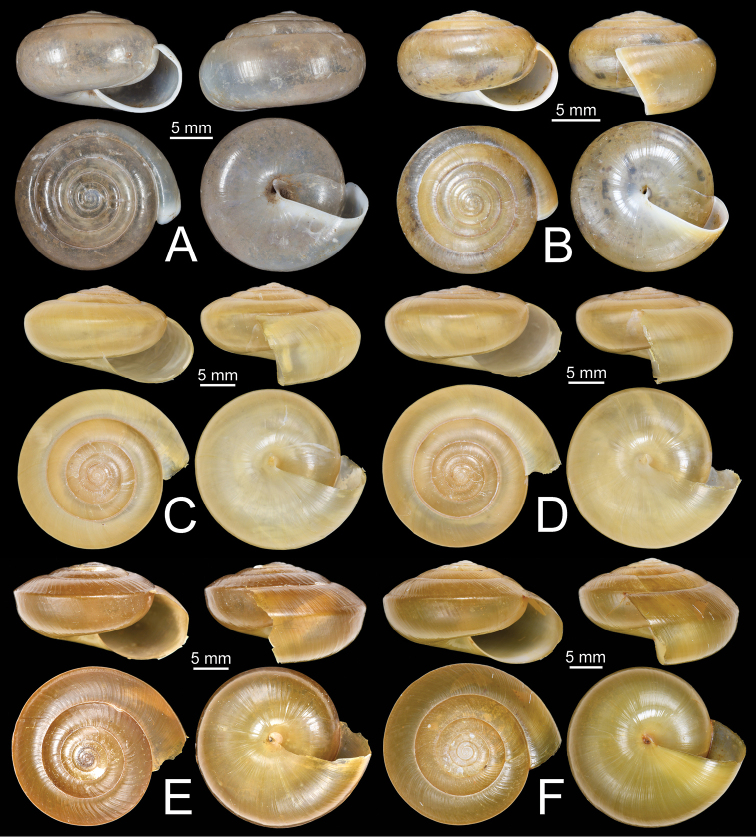
Shells of Group III: Sarika
dugasti group. A, BSarika
dugastiA syntype MNHN-IM-2000-27884 and B specimen CUMZ 7542, C–FS.
solemi sp. nov. C holotype CUMZ 7297 D paratype CUMZ 7298, and E, F specimen CUMZ 7503.